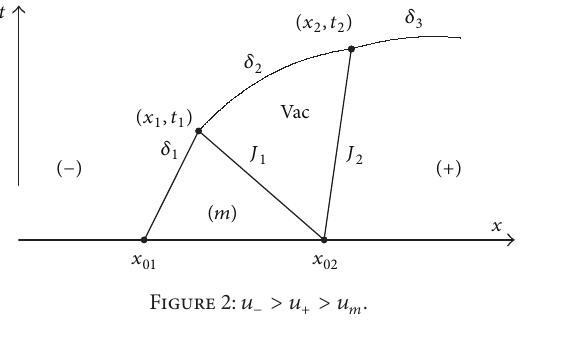
Figure 2: 𝑢 − > 𝑢 + > 𝑢 𝑚 .